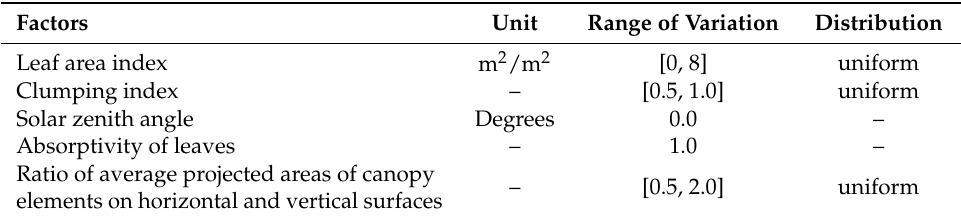
Table 2. Range of input parameters for Equation